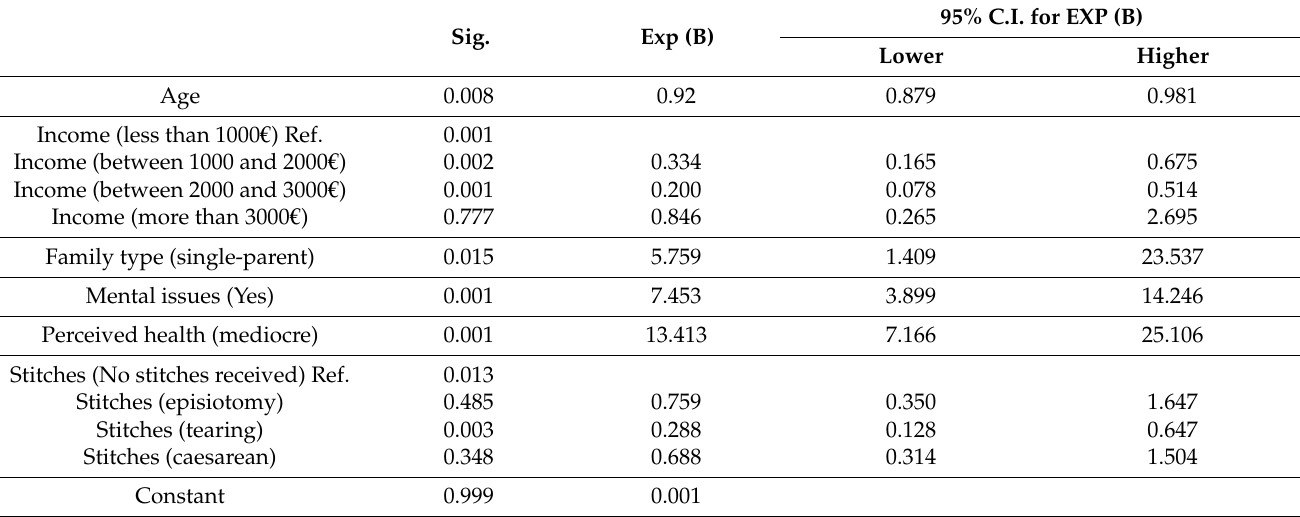
Table 4. Binary logistic regression study for the depression variable.